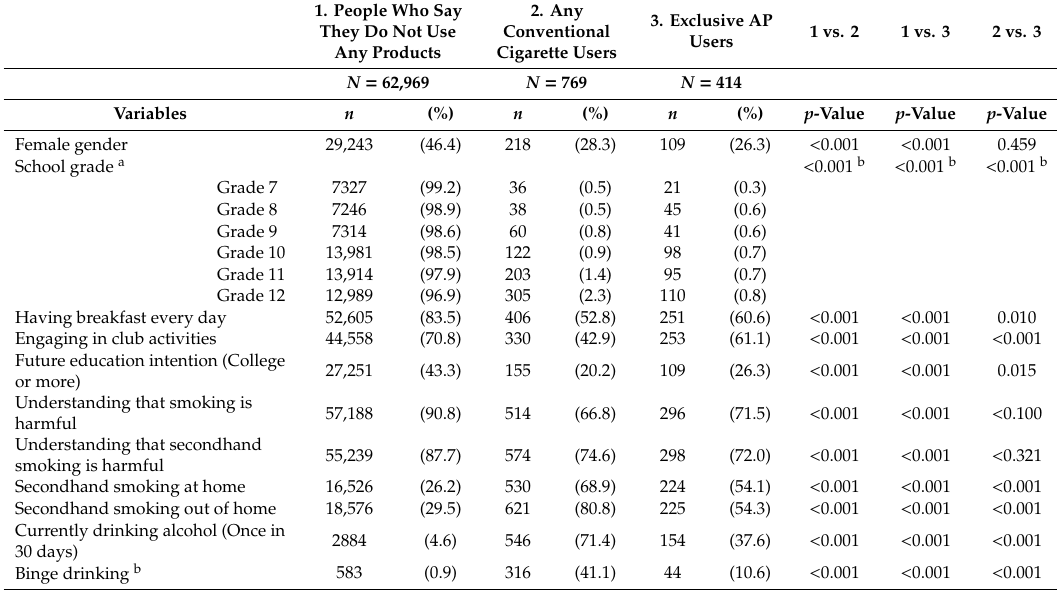
Table 2. Cross-comparison of three group: non-users with any conventional cigarette smokers and exclusive alternative-product use in youth, including demographics, lifestyles, school life and drinking